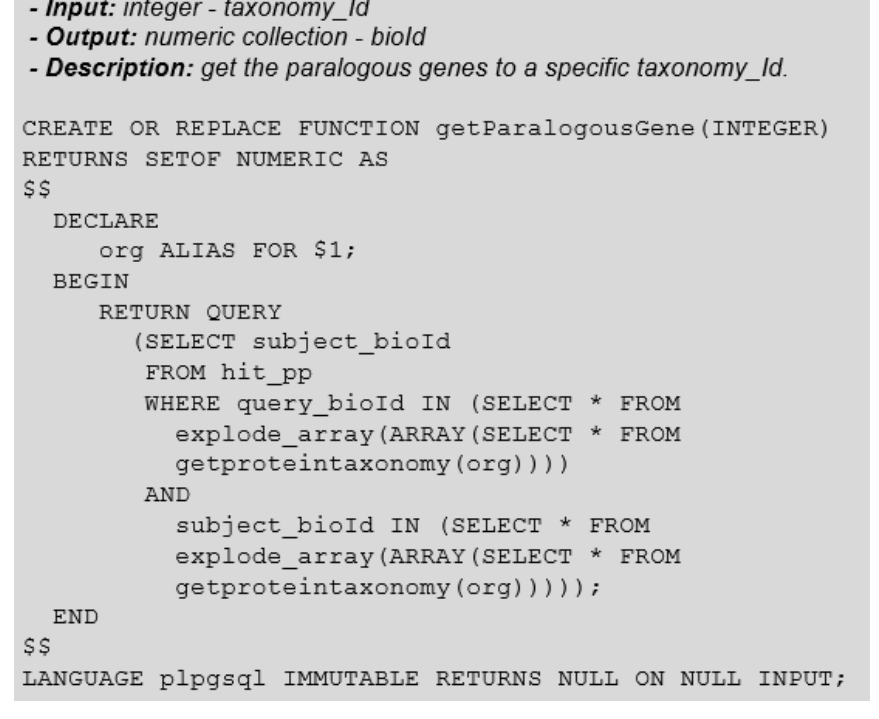
Figure 19. Function: